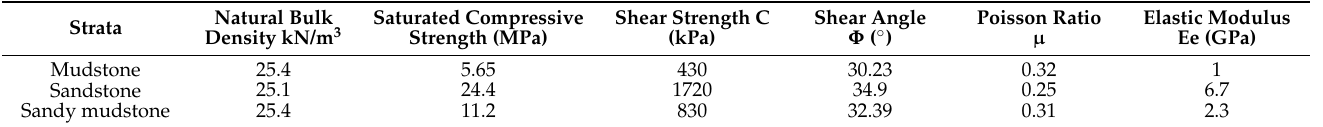
Table 1. Physical and mechanical parameters of the main rock and soil layers.